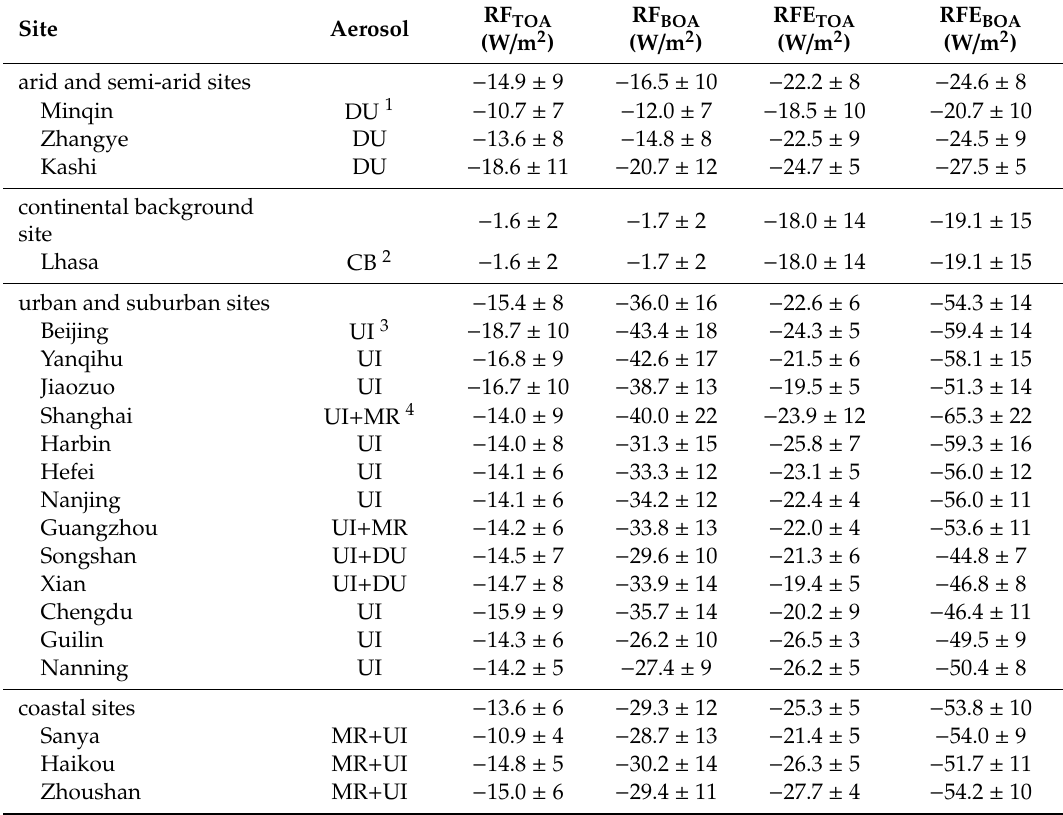
Table 3. Multi-year average aerosol radiative forcing and e ffi ciencies estimated by the Santa